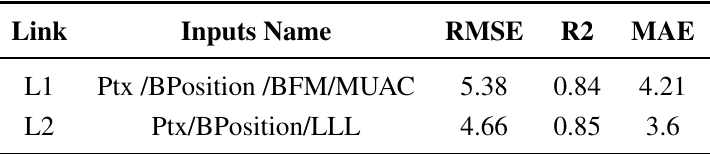
Table 3. Link quality estimator models based on ANFIS (Adaptive Neuro-Fuzzy Inference System) (A-LQE) for both links with the training dataset.